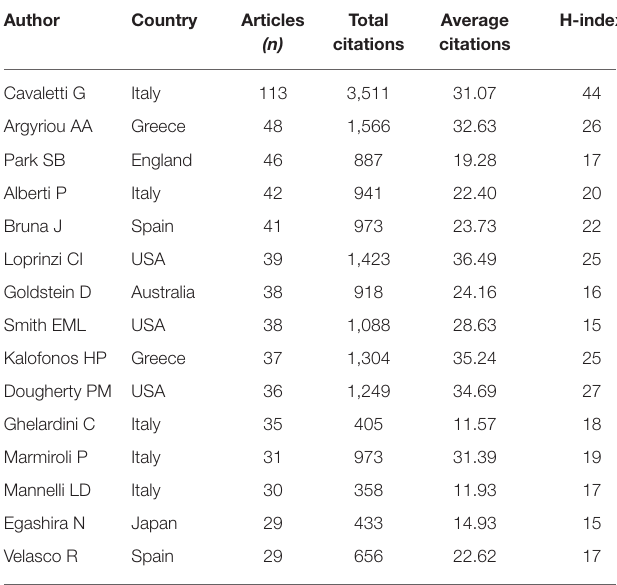
TABLE 2 | The top 15 most influential